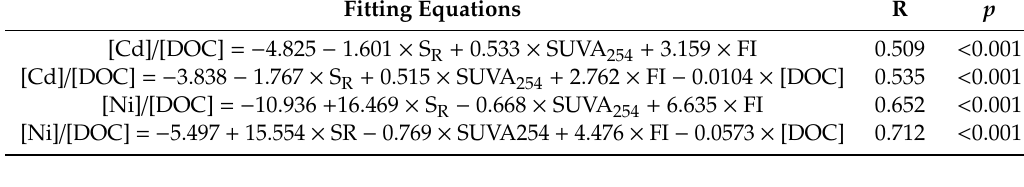
Table 5. Predicted equations of [Me] / [DOC] ratio fitted with optical indicators. Fitting Equations